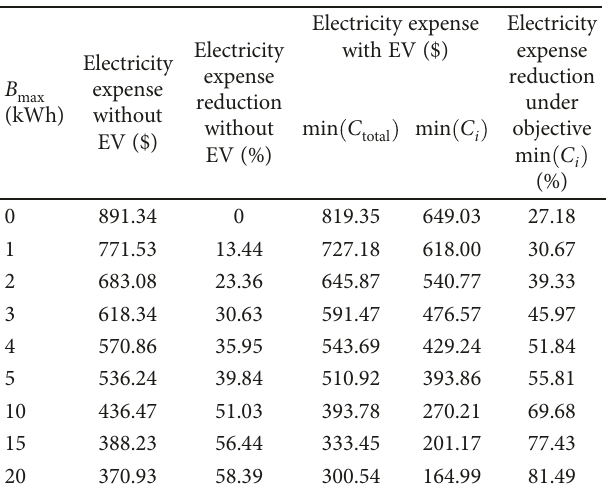
Table 1: Computing result comparison of the whole year under di ff erent